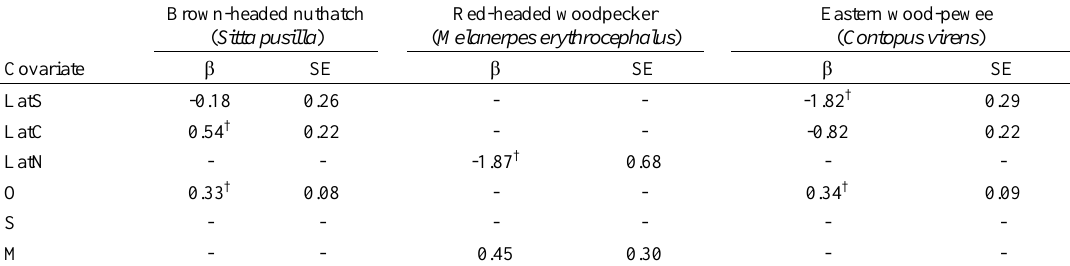
Table 2. Beta coefficients and standard errors ( β ± SE) for occupancy ( ψ ) estimates derived from models with highest support ( ∆ AIC) in the data using single season occupancy models for three avian species of conservation priority in the South Atlantic Coastal Plain, United States, 2001. Covariates were latitude: (LatS = 29-31°, LatC = 32-34°N, LatN = 35-37°N) and Hamel’s habitat suitability categories, namely, optimal (O), suitable (S), and marginal (M).